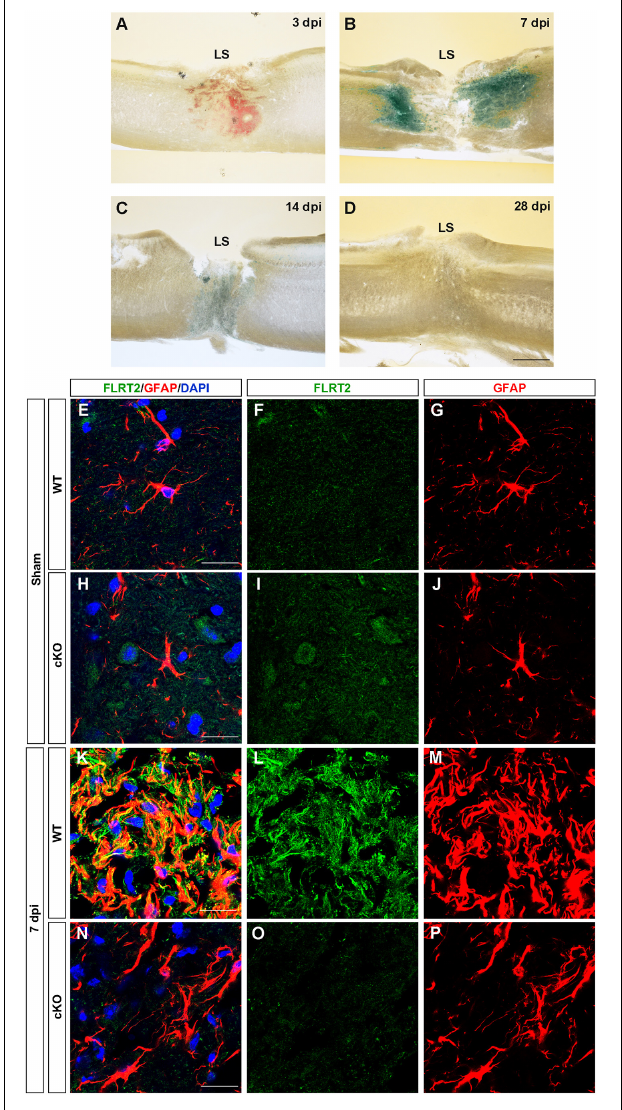
FIGURE 6 | FLRT2 is strongly expressed in astrocytes 7 days after spinal cord injury. (A–D) Sagittal slices 3, 7, 14, and 28 days after spinal cord injury, subjected to X-gal staining. Strong FLRT2 expression was observed at 7 dpi and decreased rapidly. (E–P) FLRT2 was expressed in GFAP + astrocytes at 7 dpi in wild type mice. GFAP induction after spinal cord injury was decreased in FLRT2 cKO. n = 3 for each group. dpi, days post-injury; LS, lesion site. Scale bars, 500 µ m (A–D) ; 20 µ m (E–M)